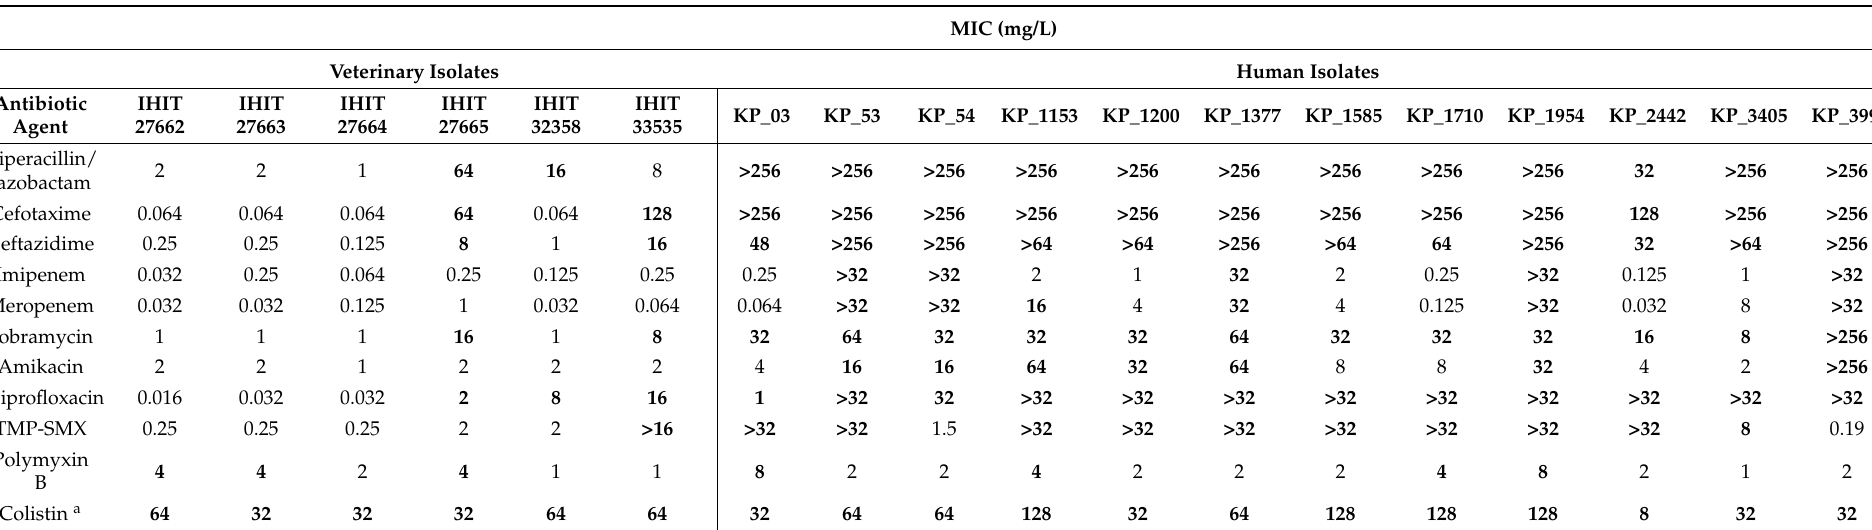
Table 2. Minimum inhibitory concentrations (MIC) for COL-resistant clinical K. pneumoniae isolates. MIC were determined employing antibiotic gradient strips unless otherwise indicated. MIC indicating resistance according to EUCAST breakpoints are highlighted in